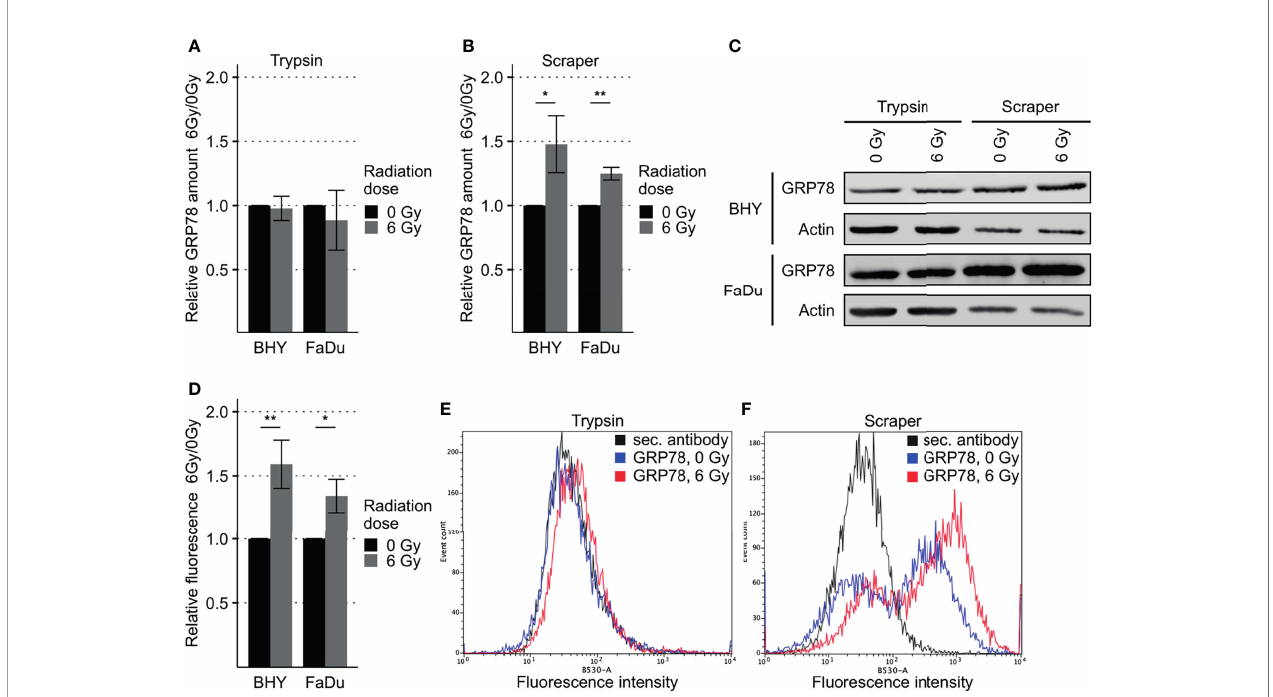
FIGURE 2 | Increased GRP78 expression on the surface of irradiated HNSCC cells. (A – C) Western Blot analysis of GRP78 expression in non-irradiated (0 Gy) and irradiated (6 Gy) HNSCC cells harvested with trypsin show no difference (A) . Cells harvested with a cell scraper show an increase in GRP78 after irradiation (B) . GRP78 expression was normalized to beta-actin and 0 Gy samples served as baseline (n = 4, t-test, *p < 0.05, **p < 0.01). (C) Representative Western Blot images of GRP78 expression in BHY and FaDu cells. Beta-actin was used as loading control. (D) Flow cytometry analysis of surface GRP78 in 0 Gy and 6 Gy-irradiated HNSCC cells con fi rmed increased GRP78 expression after irradiation. Samples were normalized to secondary antibody signal and 0 Gy (n = 4, t-test, *p < 0.05, **p < 0.01). (E, F) Example histograms of GRP78 fl uorescence intensity from BHY cells harvested with either Trypsin (E) , showing no difference in intensity, or a cell scraper (F) , showing an increase of signal intensity in irradiated